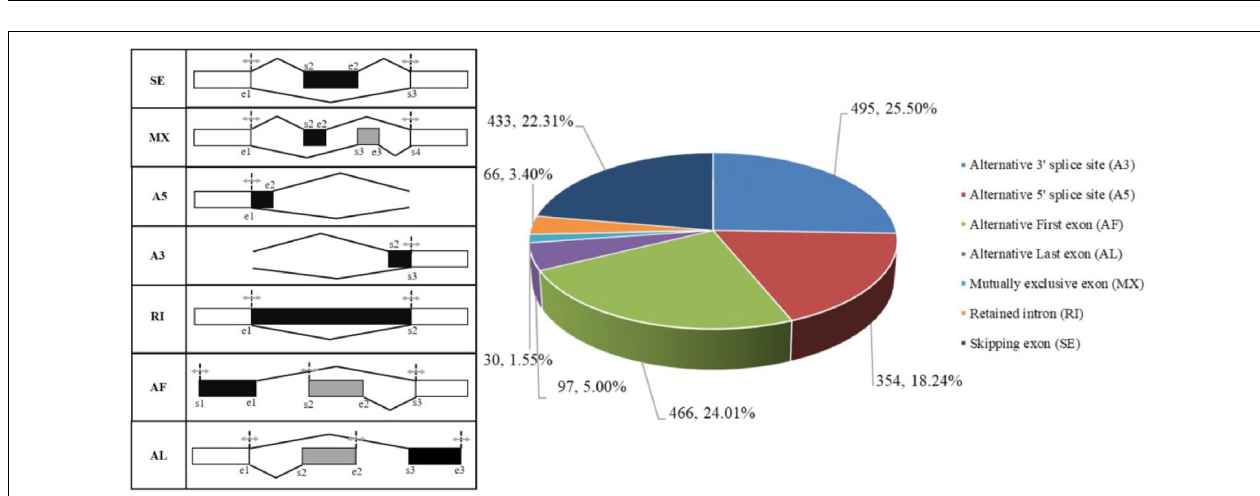
FIGURE 4 | The density distribution of known and novel transcripts on the longest FL transcripts.